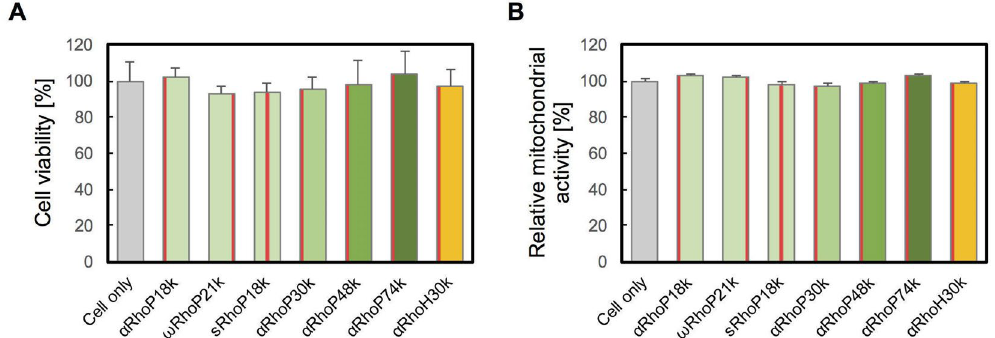
Figure 2. ( A ) Viability of HeLa cells treated with RhoPs (1.0 mg/mL). After addition of each polymer, cells were incubated at 37 °C, 5% CO 2 for 24 h. The number of cells was evaluated by the Trypan blue assay. (n = 4) ( B ) Relative mitochondrial activity of HeLa cells 24 h upon RhoPs addition. The mitochondrial activity was evaluated by the MTT assay. (n = 4) The red column in each bar of the graph indicates the position of Rho on the polymer. Left: α RhoP, Middle: sRhoP, Right: ω